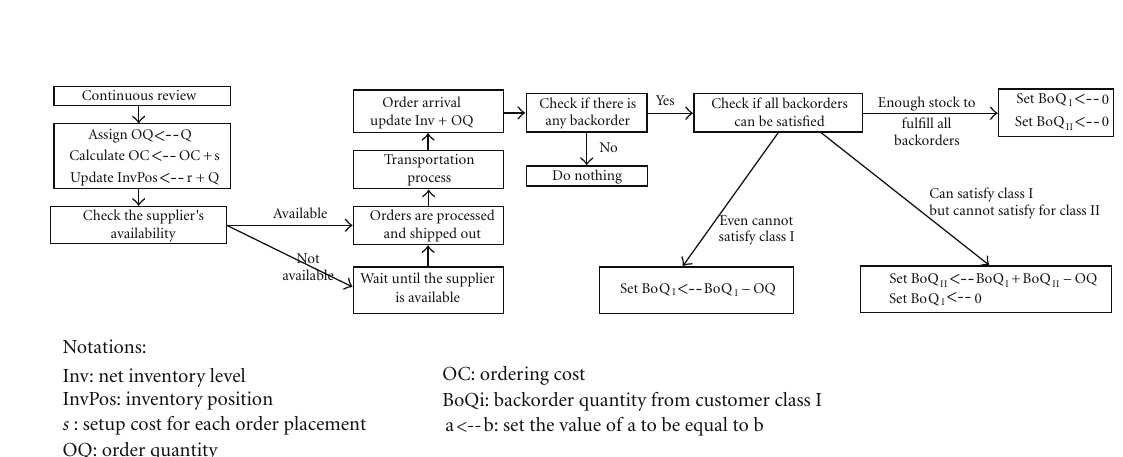
Figure 3: Customer demand subsystem.